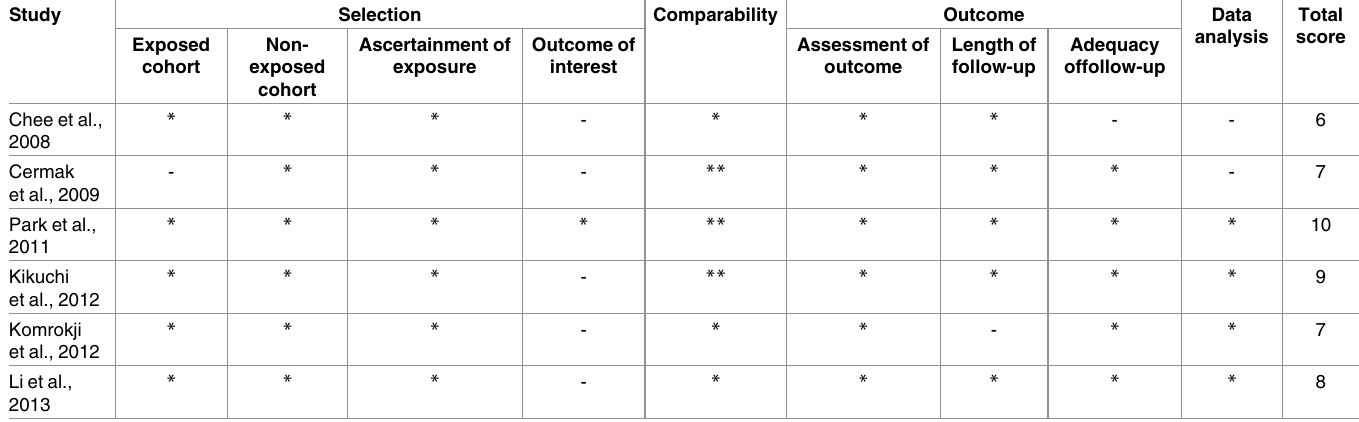
Table 1. Methodological quality assessment (risk of bias) of included studies by Newcastle-Ottawa Scale. For each domain,either a "star" or "no star" is assigned,with a "star" indicating that study designelement was considered adequateand less likely to introducebias. A maximum of two stars can be given for Comparability. A study could receivea maximum of ten